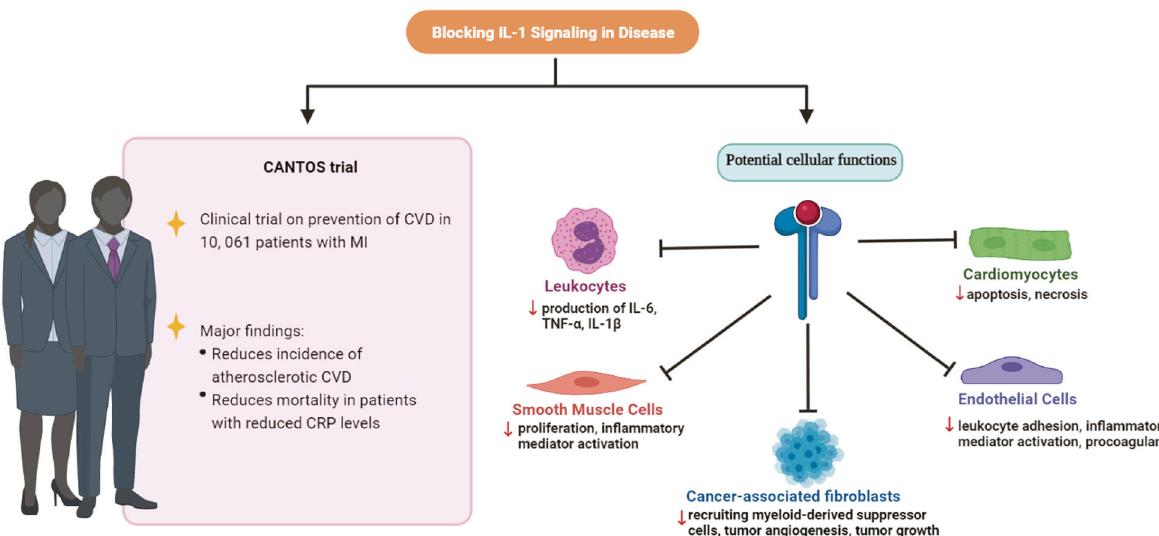
Fig. 6 Mechanisms underlying the bene fi cial effect of IL-1 blockade in treating cardiovascular diseases and cancer. The CANTOS trial showed a reduced incidence of CVD in patients treated with canakinumab, a monoclonal antibody blocking IL-1 β . The potential mechanisms underlying the bene fi cial effects of IL-1 targeting strategies include inhibition of cardiomyocyte apoptosis and necrosis, reduction of in fl ammatory mediator activation in endothelial cells, prevention of recruitment of tumor suppressor cells, and inhibition of tumor angiogenesis and